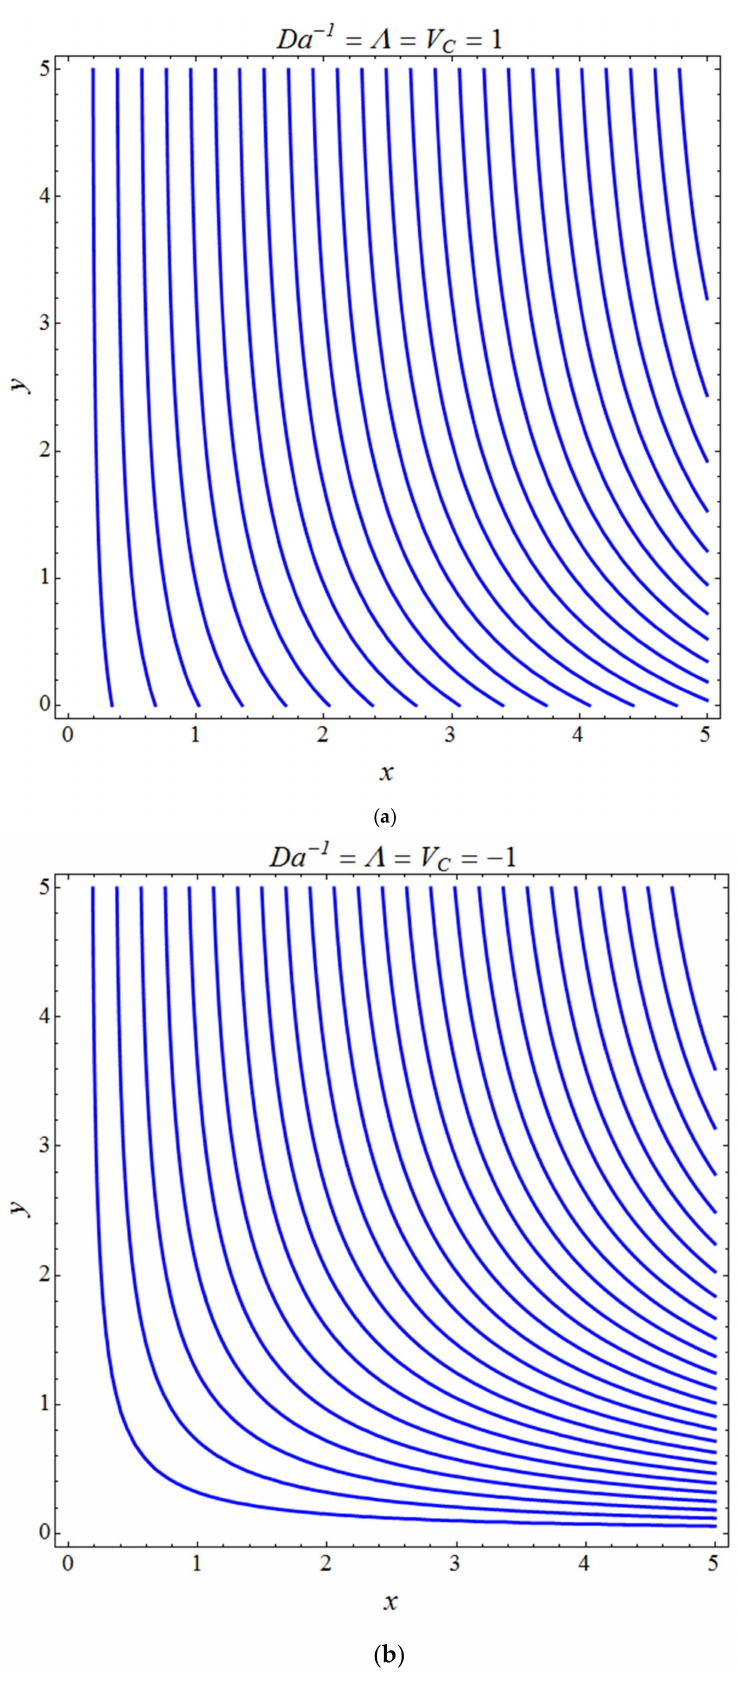
Figure 16. Pattern of streamline flows for ( a ) suction and ( b ) injection